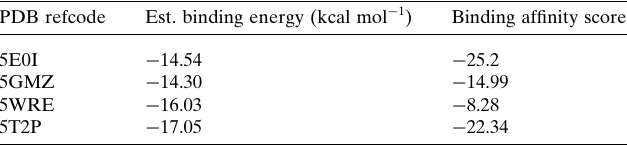
Table 3 Binding affinity parameters of title molecule with HBV core proteins. PDB refcode